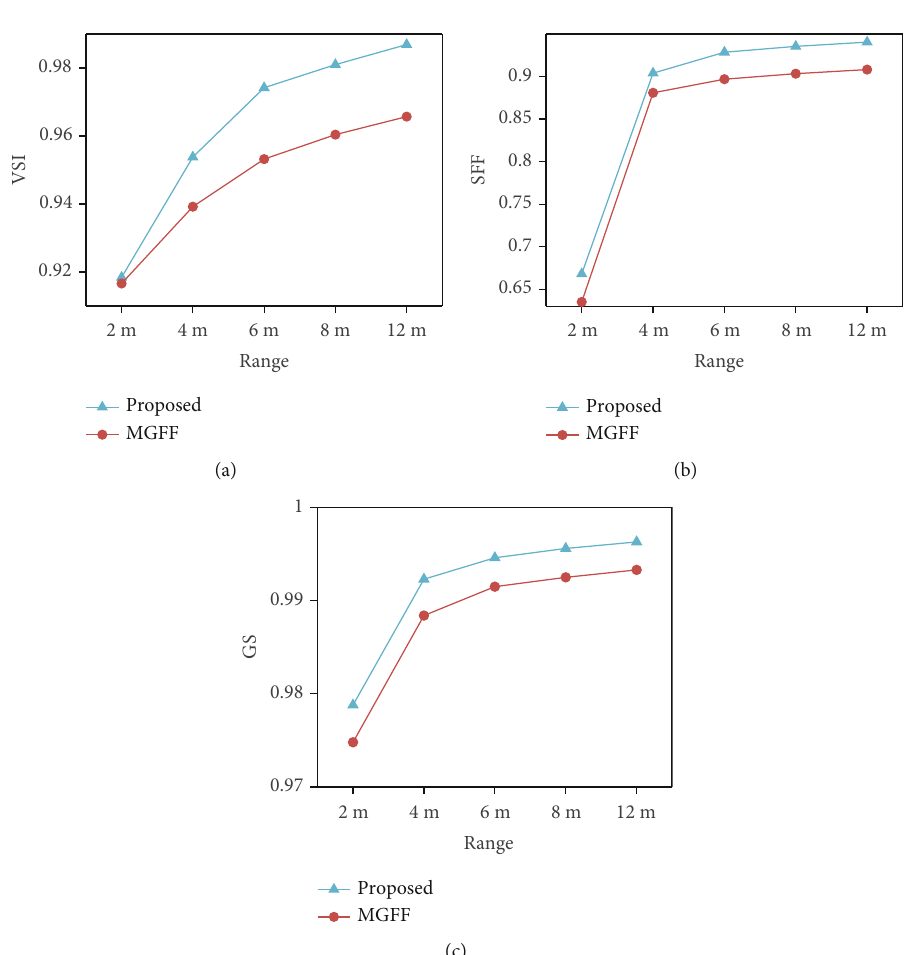
Figure 13: Fusion performance in di ff erent imaging